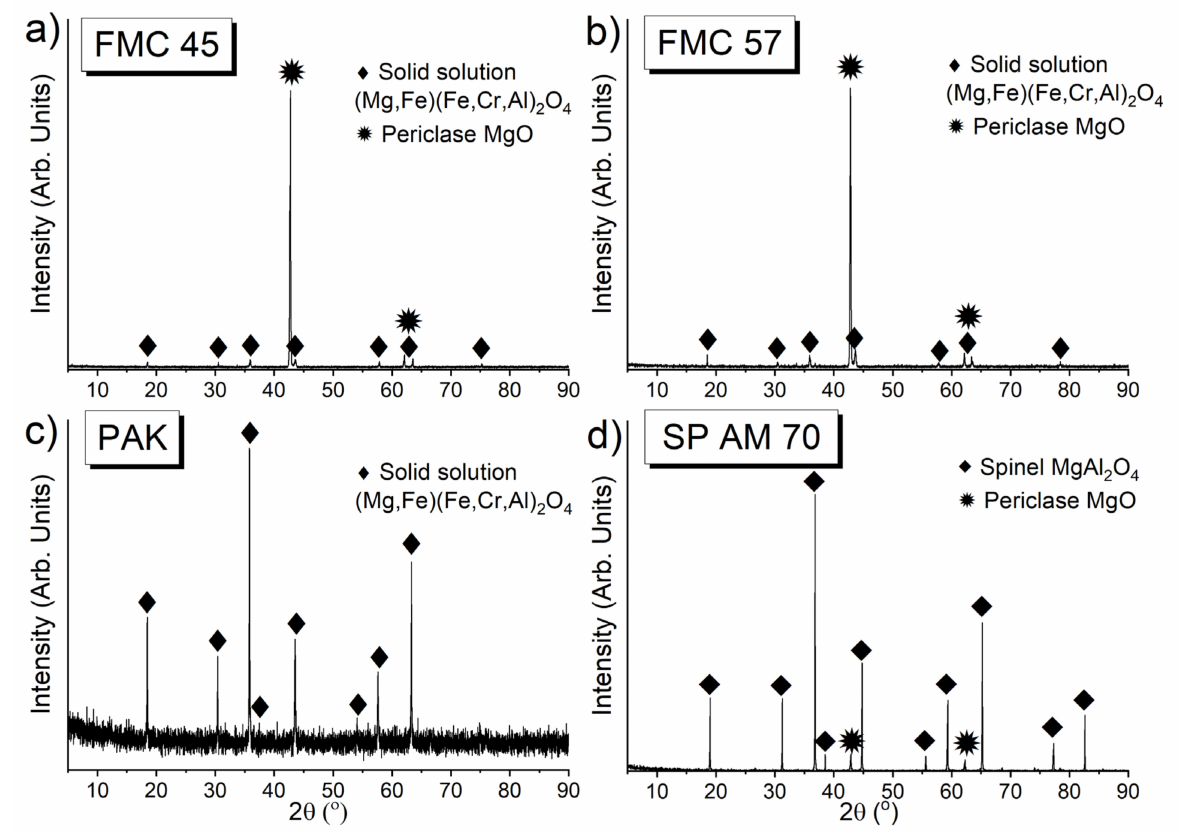
Figure 1. XRD patterns of ( a ) FMC 45, ( b ) FMC 57, ( c ) PAK, ( d ) SP AM 70.